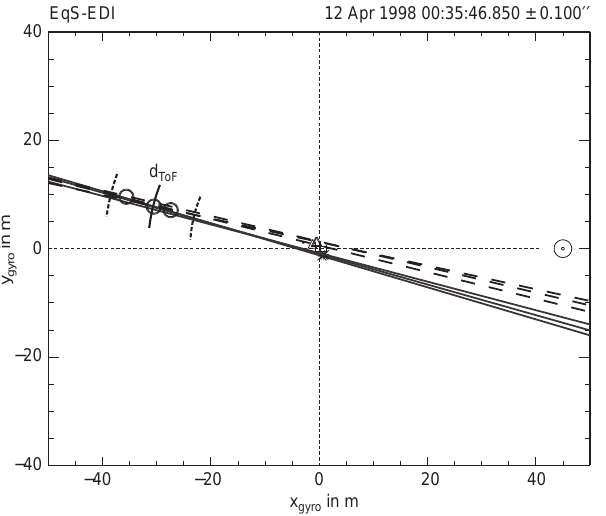
Fig. 5. Comparison of triangulation and time-of-flight results. The figure shows the gun locations, projected into the gyro-plane (x gyro , y gyro ), and the firing directions, for the 0.2-s interval marked by the grey-shading in Fig. 4. Solid straight lines indicate the firing directions from Gun 1 ( crosses ), dashed lines those from Gun 2 ( triangles ). Triangulation of the drift step, based on these directions and a correction for curvature of the electron trajectories, yields the positions marked by the open circles . The drift step calculated from the measured di(cid:128)erence in the times-of-flight (31.5 m) is indicated by the line marked d ToF , and the error of the mean by the neighbouring dashed lines . A drift step of 31.5 m corresponds to a drift velocity of 42 km s (cid:255) 1 , equivalent to an electric field of 2.0 mV m (cid:255) 1 . The drift is directed to the right, or sunward, as indicated by the sun-symbol